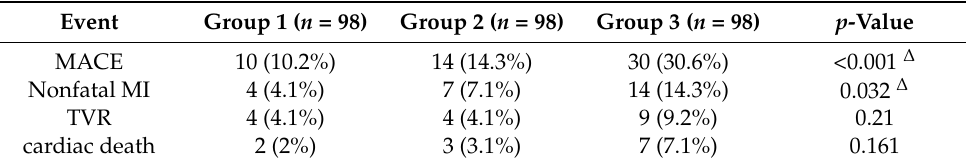
Table 3. Clinical outcomes in AMI patients based on fT3/fT4 ratio tertiles.